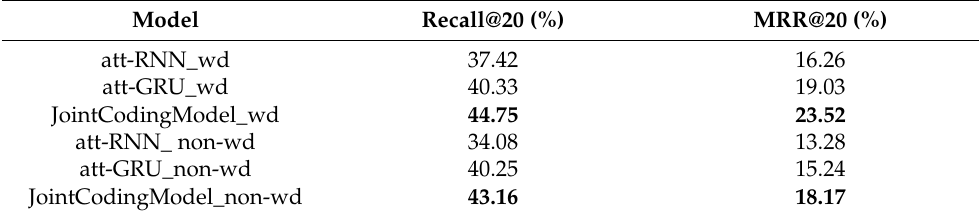
Table 4. Experimental results of the workday and non-workday group.